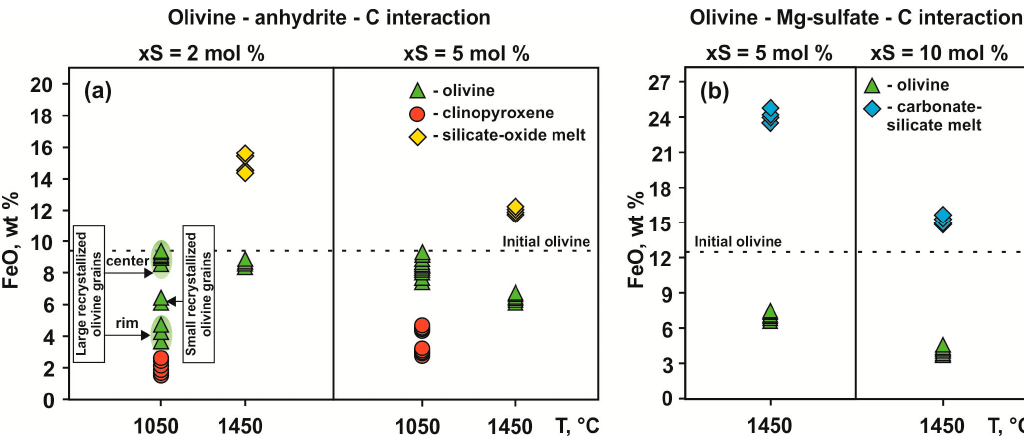
Figure 4. Temperature and sulfur content (xS) dependencies of FeO concentrations in silicates and silicate-oxide melts. Minerals 2018 , 8 , x FOR PEER REVIEW Table 3. Compositions of silicates, silicate-oxide and carbonate-silicate melts. xS, Run N T, °C Phase N A mol %